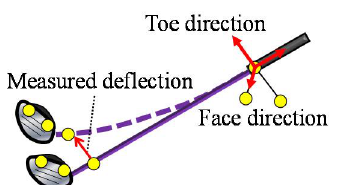
Figure 5. Markers were attached to the grip, tip of the shaft, and head. The rotation coordinate system on the grip was composed of three directions (the toe direction, face direction, and shaft axis direction). Using this coordinate system and the position of the marker attached to the tip of the shaft, we computed the measured deflection of the tip of the shaft in the toe and face direction.